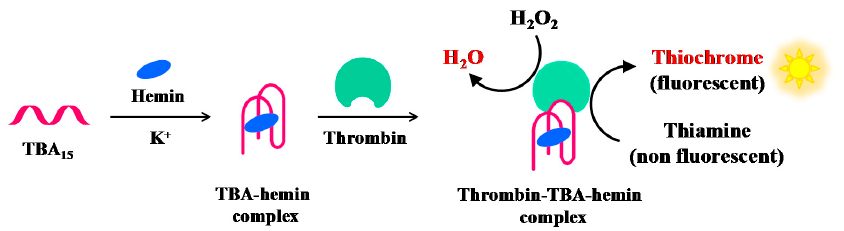
Figure 11. Schematic representation of the fluorescence thrombin detection based on the DNAzyme formation between the hemin-TBA complex and thrombin, as described in reference [109].